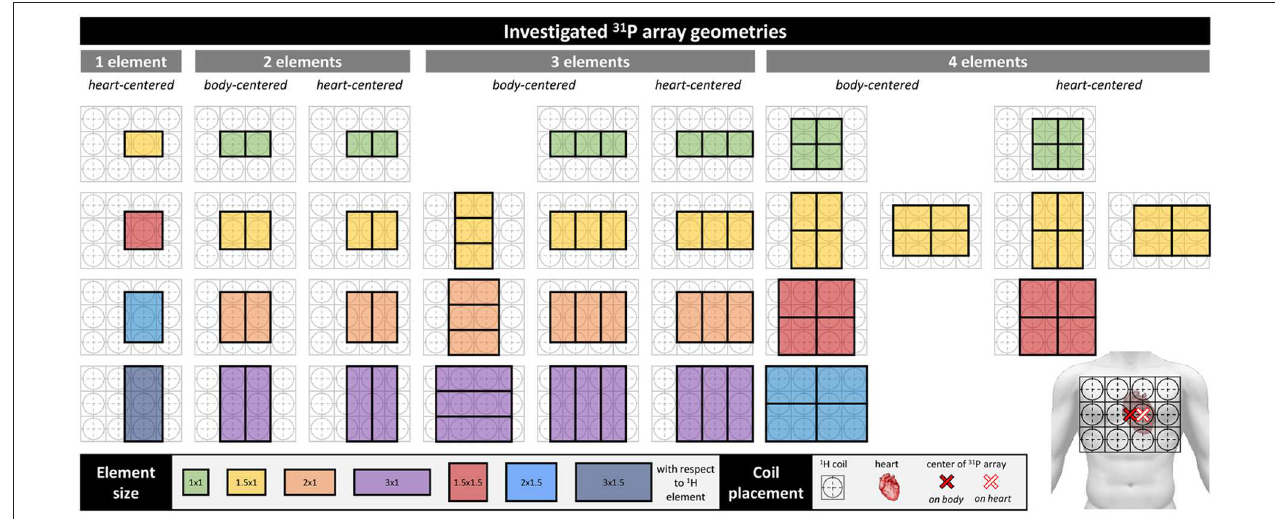
FIGURE 1 | Simulated array designs. The designs are grouped by the number of channels, i.e., 1–4 elements. Each group is divided in body-centered (bc) and heart-centered (hc) arrays. bc-arrays are centered above the sternum, hc-arrays are shifted by half a housing box to the left, to be centered above the heart, as indicated on the torso on the bottom right. Colors represent the size of the individual elements, as stated in the legend on the bottom, the numbers are the element sizes in multiples of the underlying 12-ch 1 H array housing boxes (grid on torso, bottom right); one unit cell has a length of 94mm.